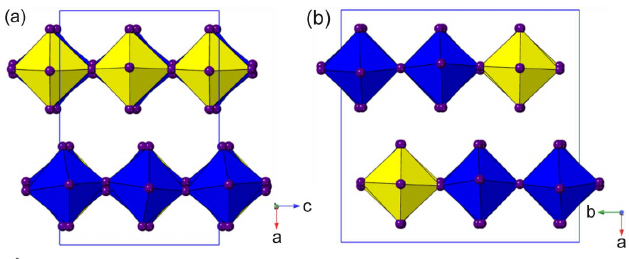
Figure 15 [CH 7 N 2 ] 2 PbI 4 (1937299) showing ( a ) no tilting of the Pb1 (yellow) and out-of-phase tilting of Pb2 (blue) octahedra around b . ( b ) Highlights that every third octahedron along the b axis is unique, giving rise to unit cell tripling.